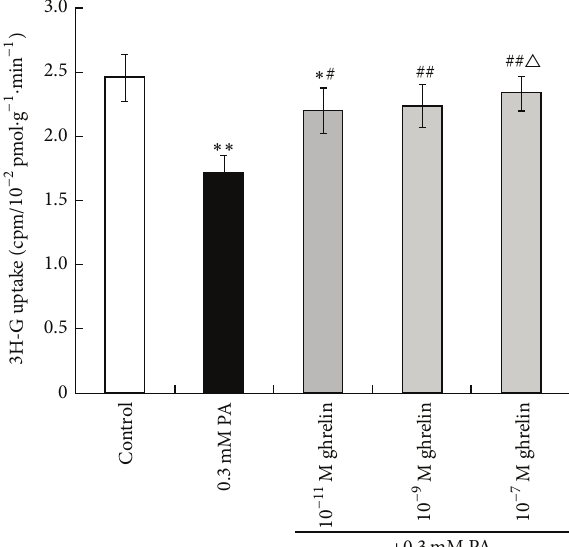
Figure 4: Effects of acylated ghrelin on glucose uptake in primary cultured rat myoblasts under high fat conditions. The uptake of 2-deoxy-D-[ 3 H] glucose was measured by the isotope tracer technique. Data are shown as mean ± SD. ∗ 𝑃 < 0.05 , ∗∗ 𝑃 < 0.01 versus controls; # 𝑃 < 0.05 , ## 𝑃 < 0.01 versus the 0.3 mM PA group; △ 𝑃 < 0.05 versus the 0.3 mM PA + 10 −11 M acylated ghrelin